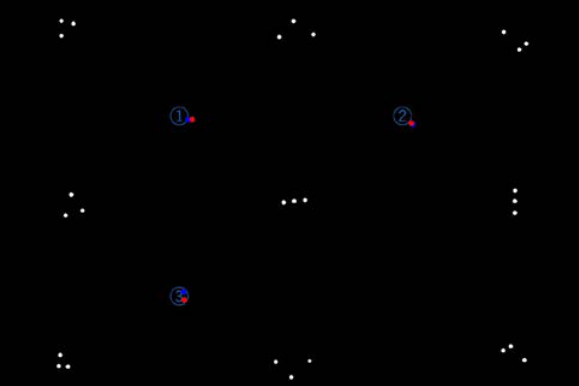
Figure 12: Result of preliminary experiment (enlarged). Eye po- sitions while watching the number 1 through 3 plotted on the projected image through the template